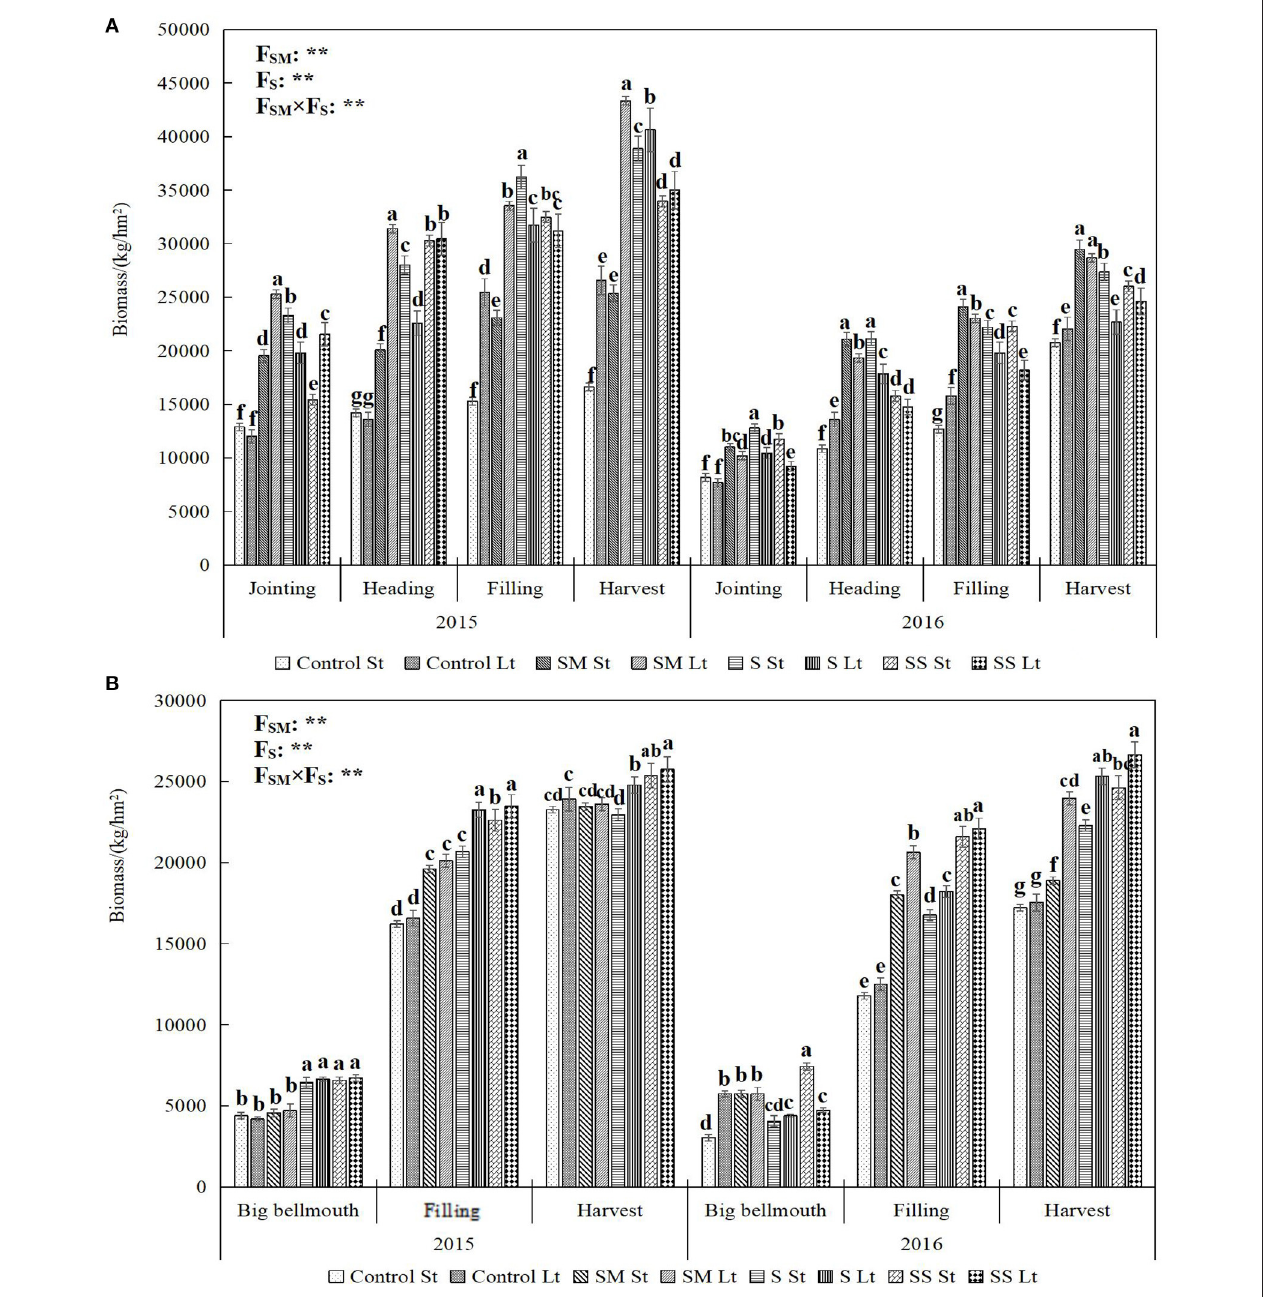
FIGURE 7 | Aboveground biomass in different growth stages of wheat (A) and maize (B) under the Control, SM, S and SS treatments. Error bars represent standard deviation ( n = 3). Columns labeled with different letters represent significant differences at P < 0.05 among treatments of two experiments at same growth stage. St, short-term; Lt, long-term; Control, conventional tillage; SM, straw mulching; S, subsoiling; SS, subsoiling + straw mulching. F SM , F S and F SM × F S mean F-values of straw mulching, subsoiling and their interactions in variance analysis respectively. “**” indicate difference at the 0.01 probability levels, respectively.